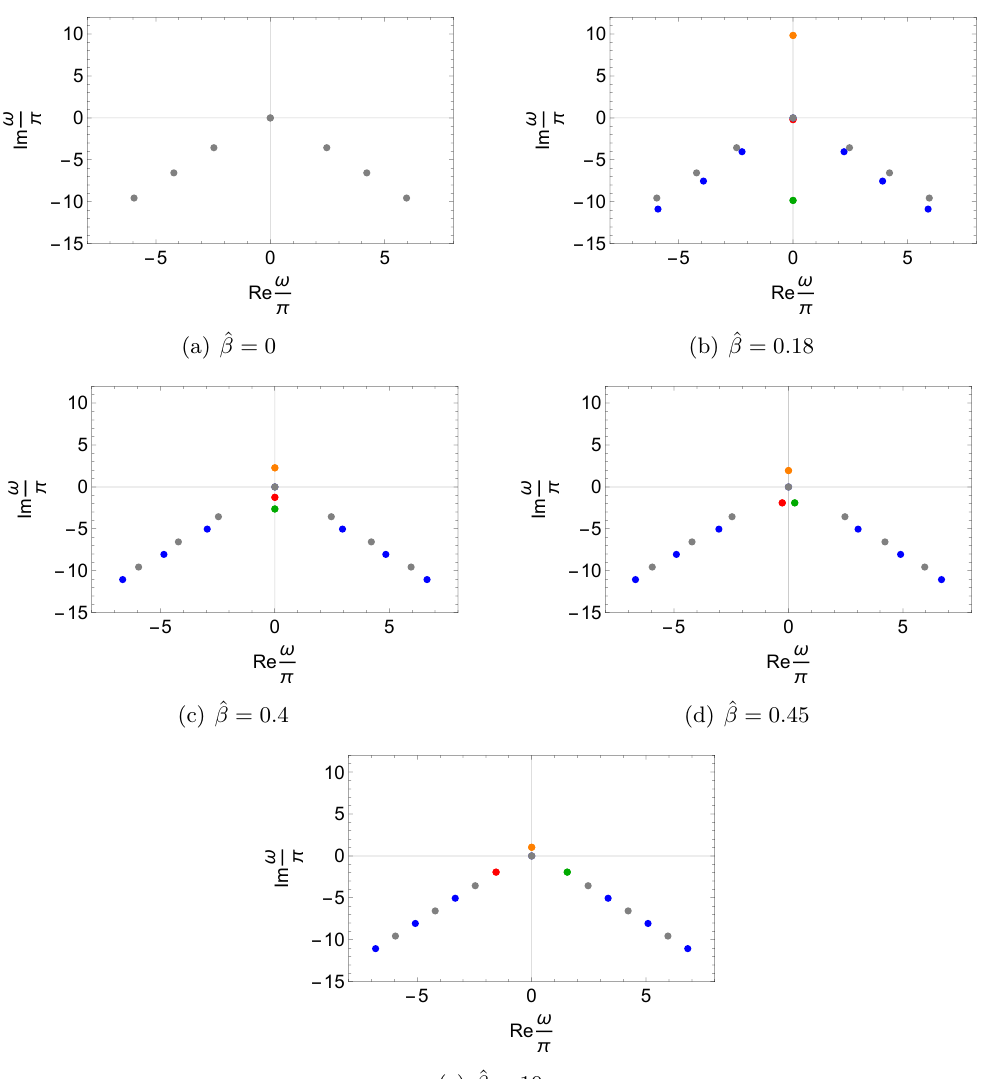
Figure 1 . Behavior of the first 8 QNMs in complex frequency plane with varying ˆ β at k = 0 are shown here. Gray dots in all figures are the QNM frequencies for ˆ β = 0 . Figure 1(a) shows the poles in the decoupling limit. Note that there are two poles at the origin corresponding to the independent constant shifts of χ and Φ . Figure 1(b) shows that at small values of ˆ β one of the poles, namely ω Q (shown in red), is displaced slightly below the origin following (3.9), while two new poles ω G (shown in green) and ω U (shown in orange) appear from − i ∞ and + i ∞ respectively on the imaginary axis. Figure 1(c) shows that with increasing ˆ β , ω G moves upward, while ω Q and ω U move downward on the imaginary axis. Eventually ω G and ω Q collide on the negative imaginary axis and transform into usual quasinormal modes as shown in figure 1(d). On the other hand ω U attains a limiting value on the positive imaginary axis as ˆ β → ∞ . As shown in figure 1(e), in the latter limit, all other QNMs (shown in blue) realign approximately on the same straight line on which the poles were located approximately in the decoupling limit but roughly at